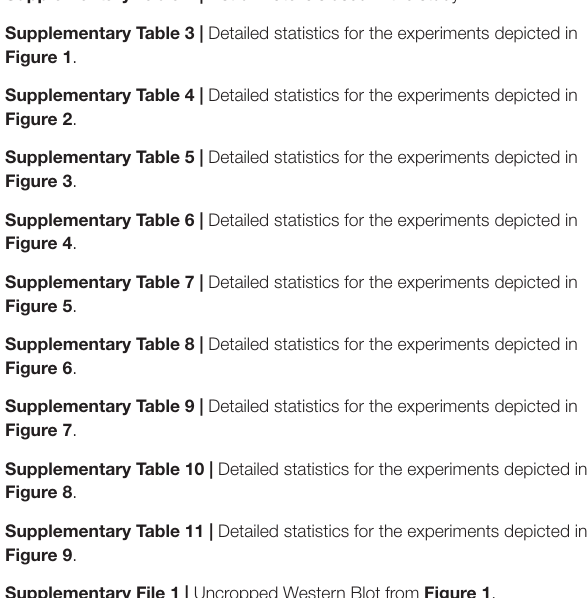
Supplementary File 1 | Uncropped Western Blot from Figure 1 . Supplementary File 2 | Uncropped Western Blot from Figure 9